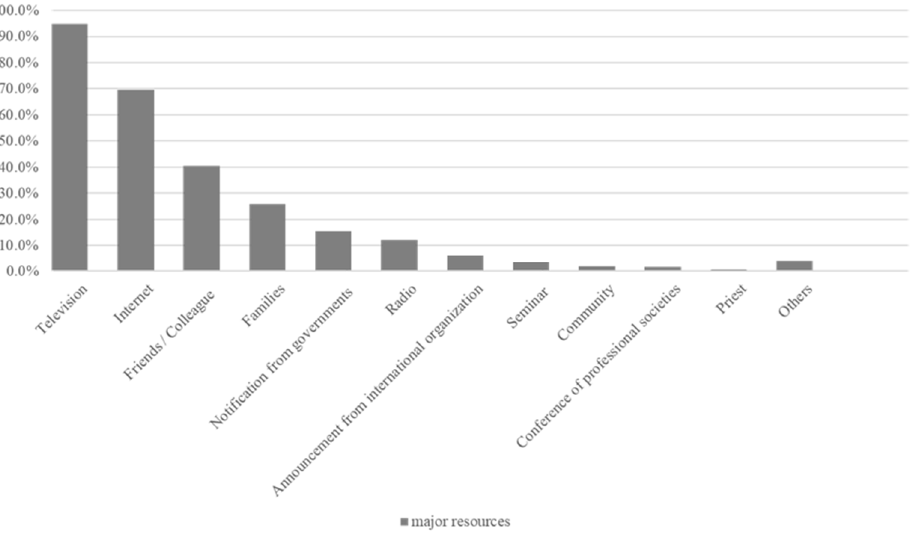
Figure 1. Information resources regarding COVID-19 among nursing care workers.